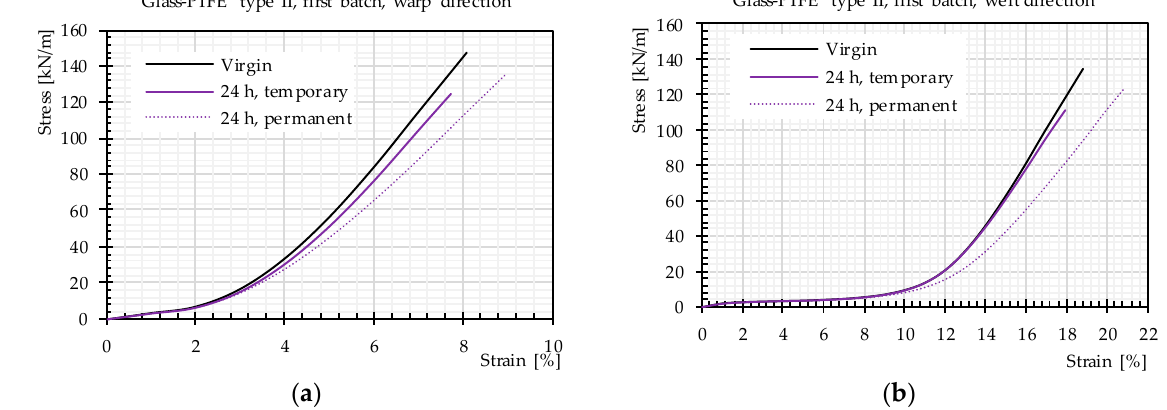
Figure 13. Permanent and temporary stress–strain curves after 24 h of watering, glass-PTFE type II first batch according to Table 3: ( a ) warp direction and ( b ) weft direction. Continuous lines: temporary changes, dashed lines: permanent changes. Regarding the recovery behavior of the stiffness after drying, no clear trend was observed (see Figure 14).